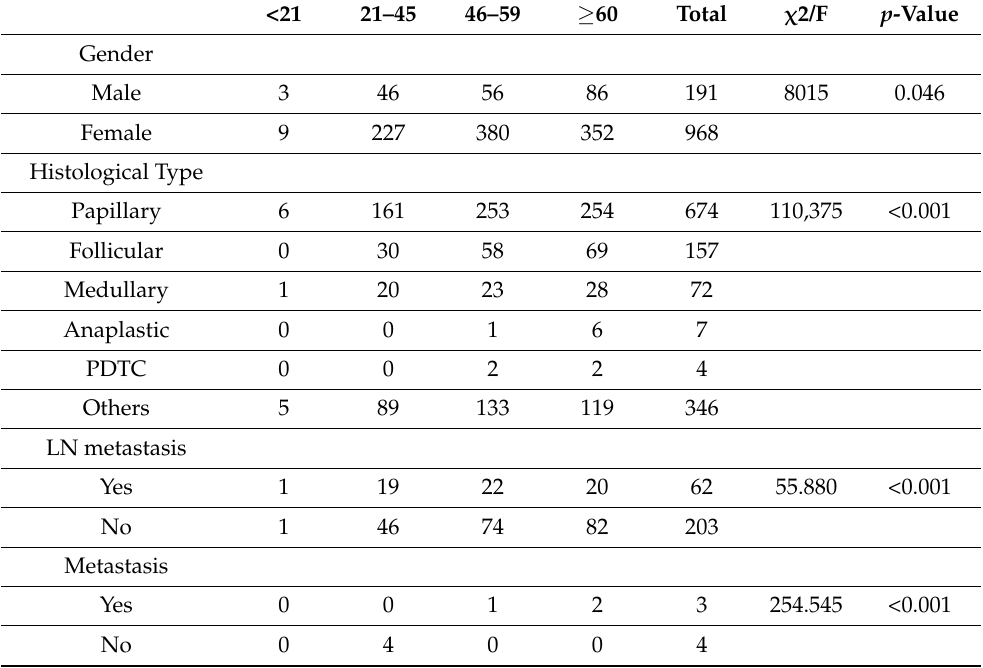
Table 5. Characteristics of thyroid cancer patients by age groups related to the Chernobyl